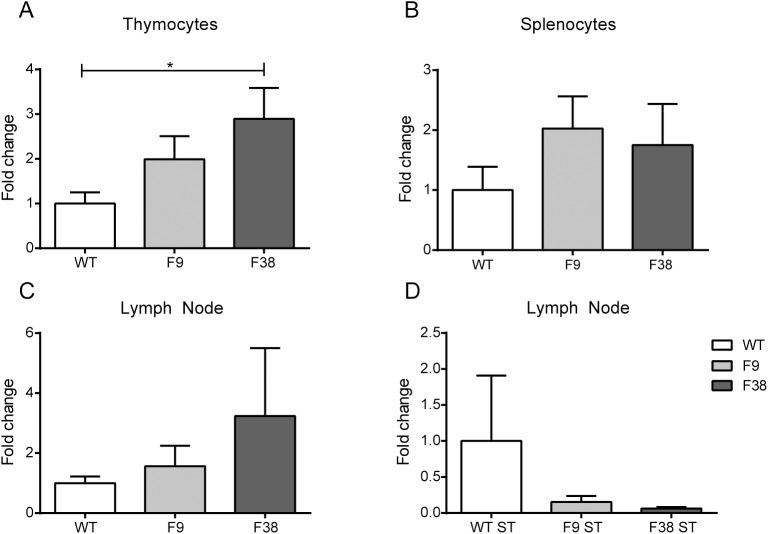
Transcription of vav is not altered in vav-CAR mice.mRNA was extracted from (A) thymocytes, (B) splenocytes of 4 week old mice, converted to cDNA and analyzed for endogenous vav1 mRNA expression by QRTPCR. Vav1 mRNA levels were normalized to the housekeeping gene β-actin. (C-D) Lymph nodes were harvested from 6–8 week old mice, dissociated into a single cell suspension and cultured overnight in the (C) absence or (D) or presence of α-CD3 and α-CD28 antibody stimulation. Cells were harvested the next day, mRNA extracted and converted to cDNA for QRTPCR analysis as above. Data represents the mean fold change in expression ± SEM of triplicate samples from 2–5 individual mice. *p<0.03. ST: stimulated.